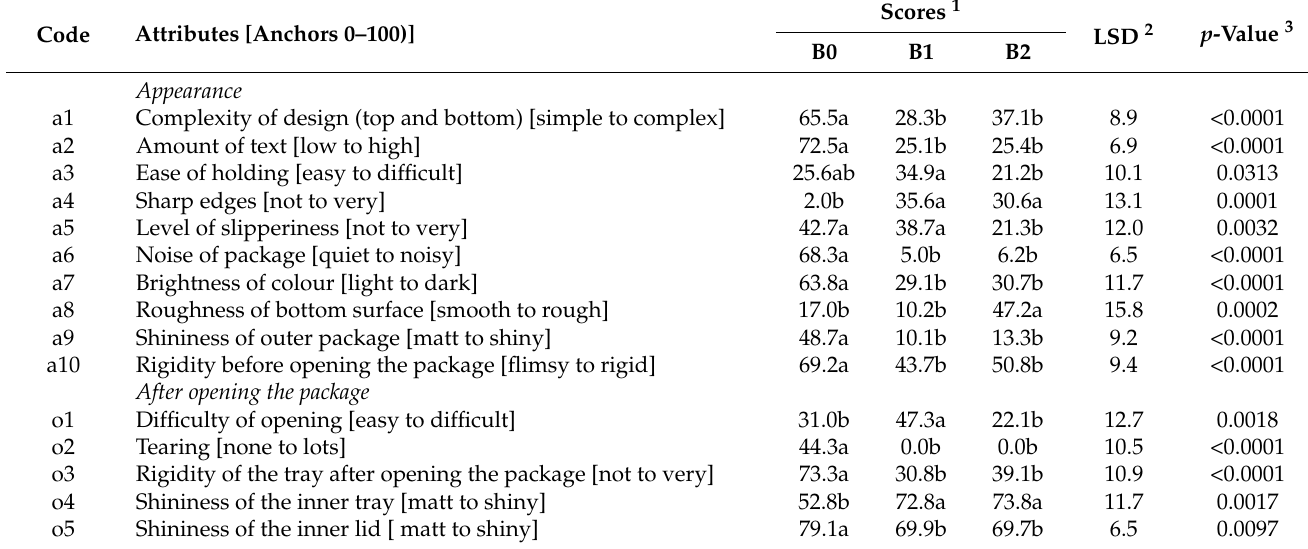
Table 2. Mean panel scores for sensory attributes of the three biscuit packages.